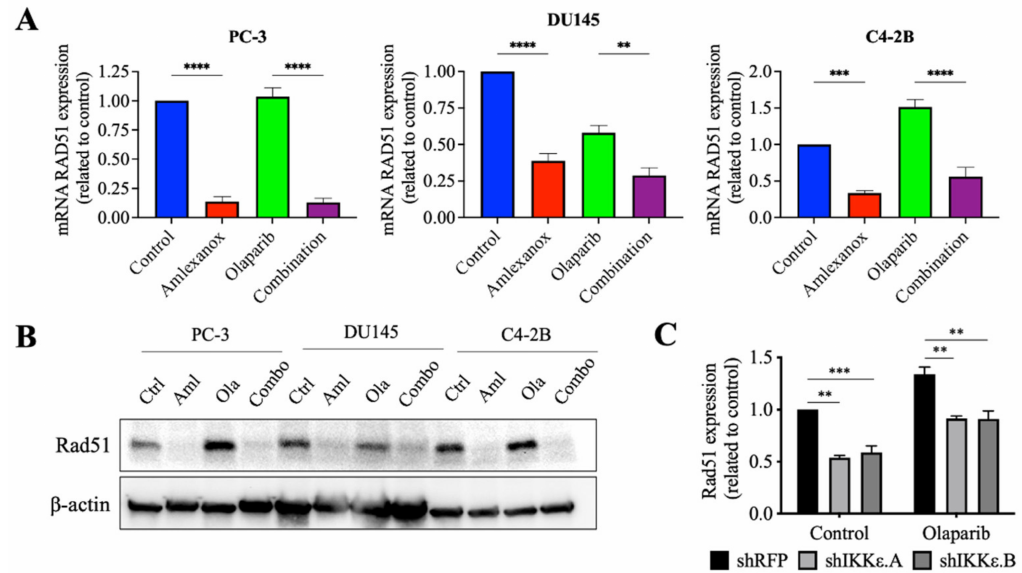
Figure 4. Amlexanox decreases Rad51 transcription and expression. ( A , B ) Rad51 expression in CRPC cells measured by RT-qPCR ( A ) and Western blot ( B ) after 48 h of 100 µ M Amlexanox (Aml) and/or 10 µ M Olaparib (Ola) treatment. ( C ) Rad51 expression in IKK ε -depleted PC-3 cells treated with 10 µ M Olaparib for 48 h and measured by RT-qPCR. Statistical significance was determined by two-way ANOVA. ** p < 0.001; *** p < 0.0001; **** p < 0.00001. The full Western blots are shown in Figure